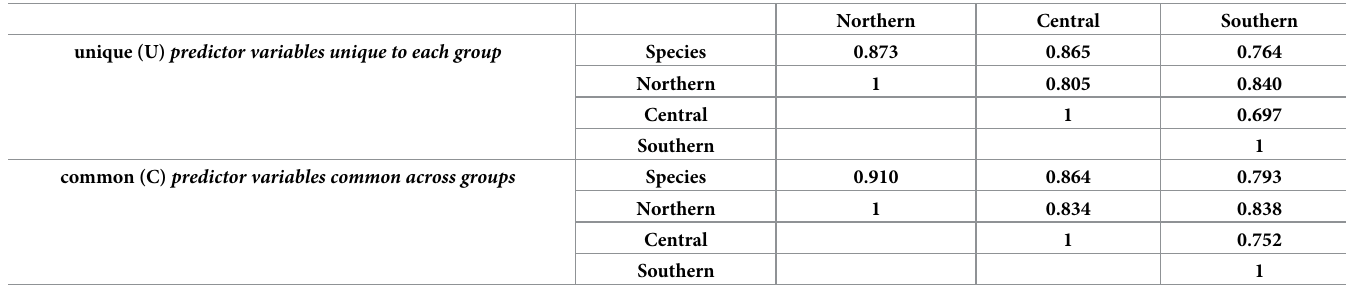
Table 3. Niche overlap measured using Schoener’s